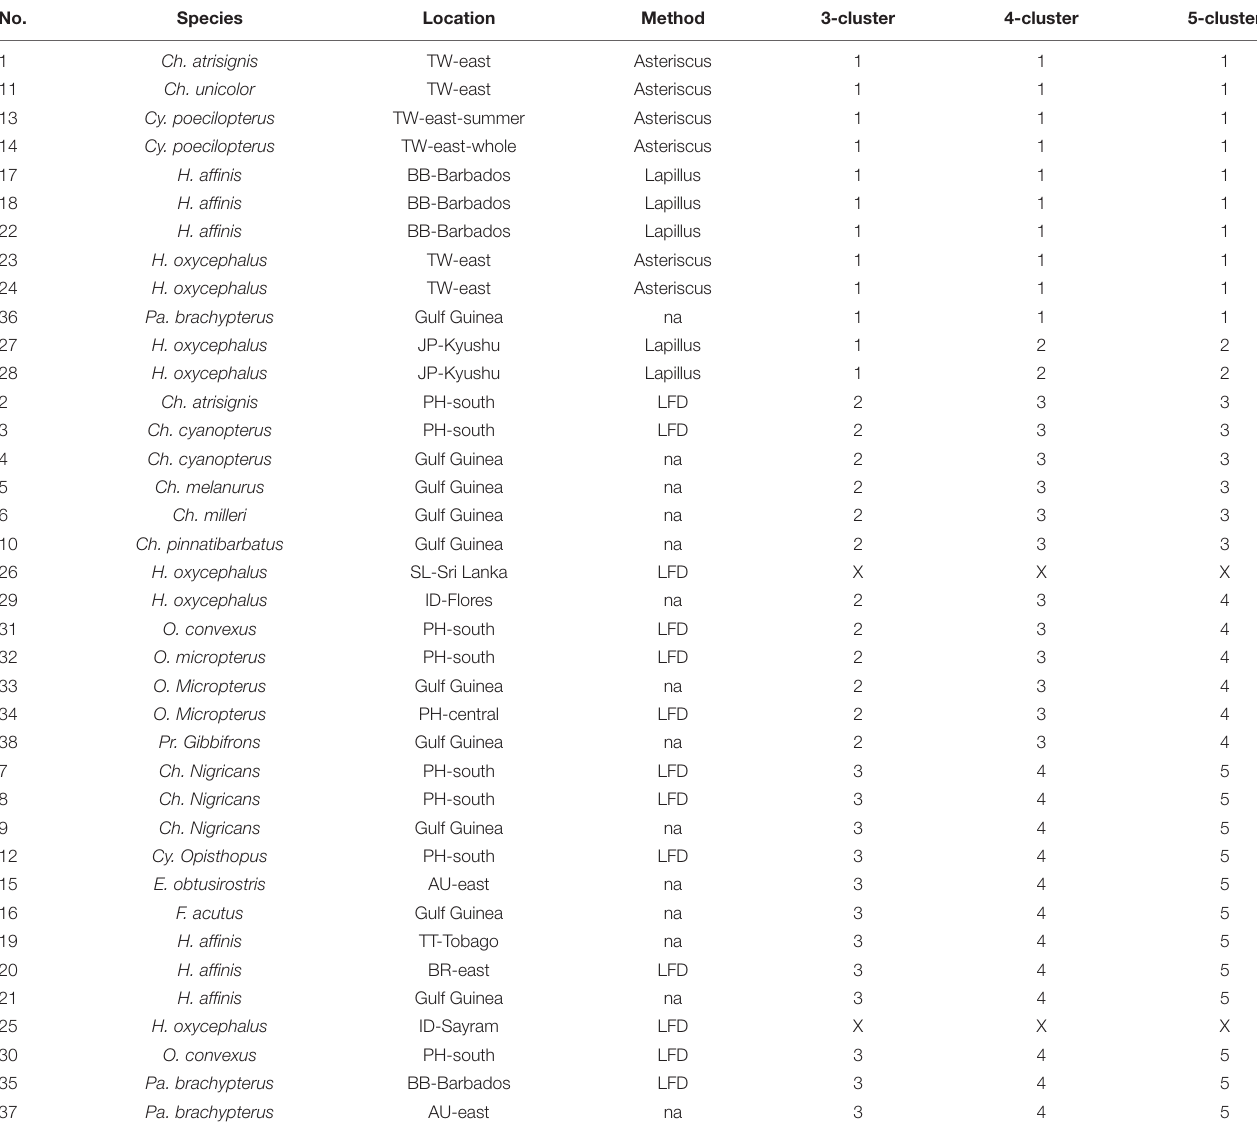
Refer to Table 2 for additional information. LFD, length frequency data. were deposited at 10.9 ( ∼ 11) days for BNY and 12.2 ( ∼ 12) days for GSP after hatching, confirming the use of the asterisci to provide a reliable estimate of